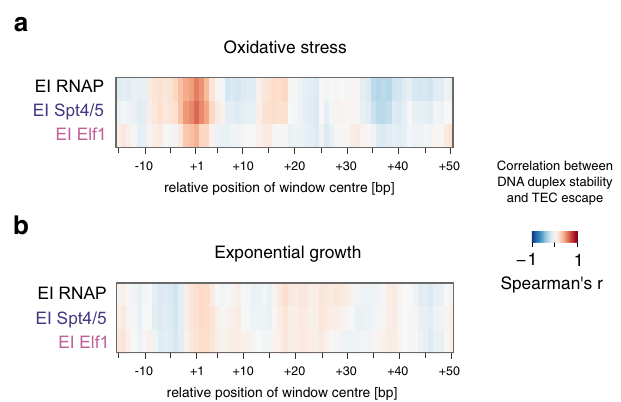
Fig. 6 DNA duplex stability around the TSS is linked to TEC escape. a , b TEC escape is sensitive to DNA duplex stability around the TSS under oxidative stress. DNA duplex stability was calculated over a 7-bp sliding window for individual promoters and correlated with the escape indices for RNAP, Spt4/5 and Elf1 (mean of two biological replicates) under oxidative stress conditions ( a ) and during exponential growth ( b ). Selected TUs with mapped TSS were included ( n = 93 for oxidative stress and n = 140 for exponential